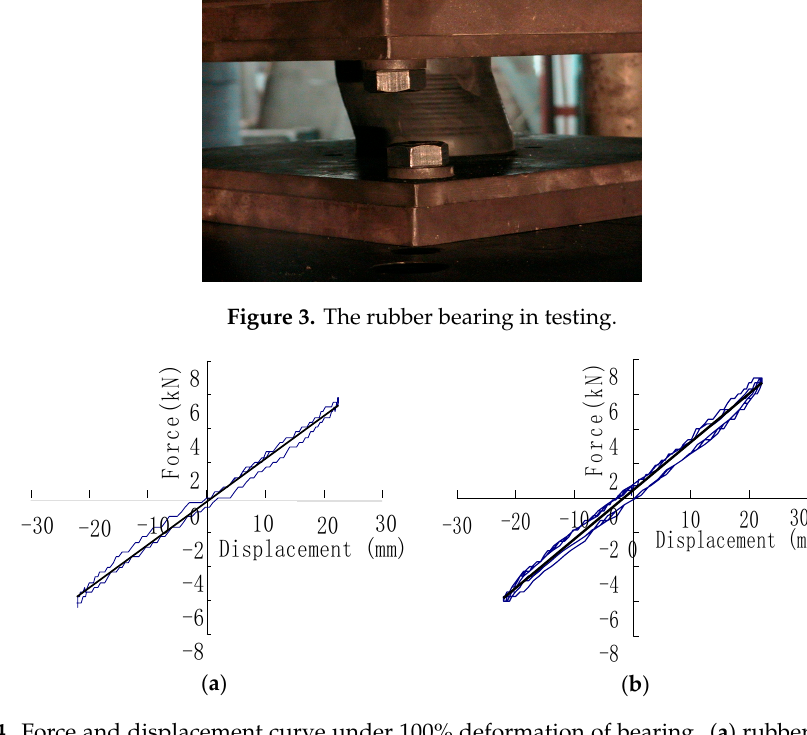
Figure 4. Force and displacement curve under 100% deformation of bearing. ( a ) rubber bearing-A; ( b ) rubber bearing-B.